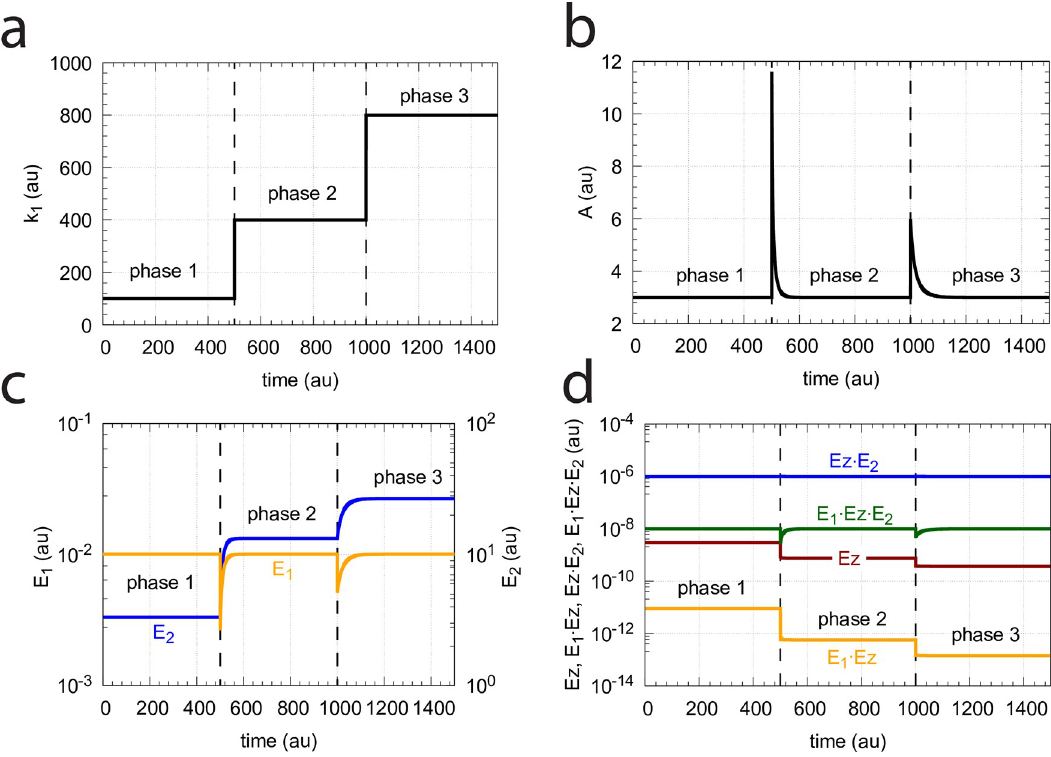
Fig 52. Homeostatic behavior towards step-wise perturbations of k 1 in the scheme of Fig 51. (a) stepwise changes of k 1 , (b) homeostatic control of A , (c) Variation of controller variables E 1 and E − 2, (d) changes in the enzymatic species Ez , E 1 � Ez , Ez � E 2 , and E 1 � Ez � E 2 . Rate constants: k 1 =100.0 in phase 1, 400.0 in phase 2, and 800.0 in phase 3. k 2 = k 3 =0.0, k 4 =1.01 × 10 1 , k 5 =31.0, k 6 =1.0, k 7 =1 × 10 8 , k 8 not used, k 9 = k 11 = k 13 = k 15 =1 × 10 8 , k 10 = k 12 = k 14 = k 16 =1 × 10 3 , k 17 =0.1. Initial concentrations: A 0 =3.000, E 1,0 =1.01 × 10 − 2 , E 2,0 =3.333, Ez 0 =2.994 × 10 − 9 , (E 1 � Ez) 0 =9.102 × 10 − 12 , (E 1 � Ez � E 2 ) 0 =1.0 × 10 − 8 , (EzE 2 ) 0 =9.871 × 10 − 7 , Ez tot =1.0 × 10 − 6